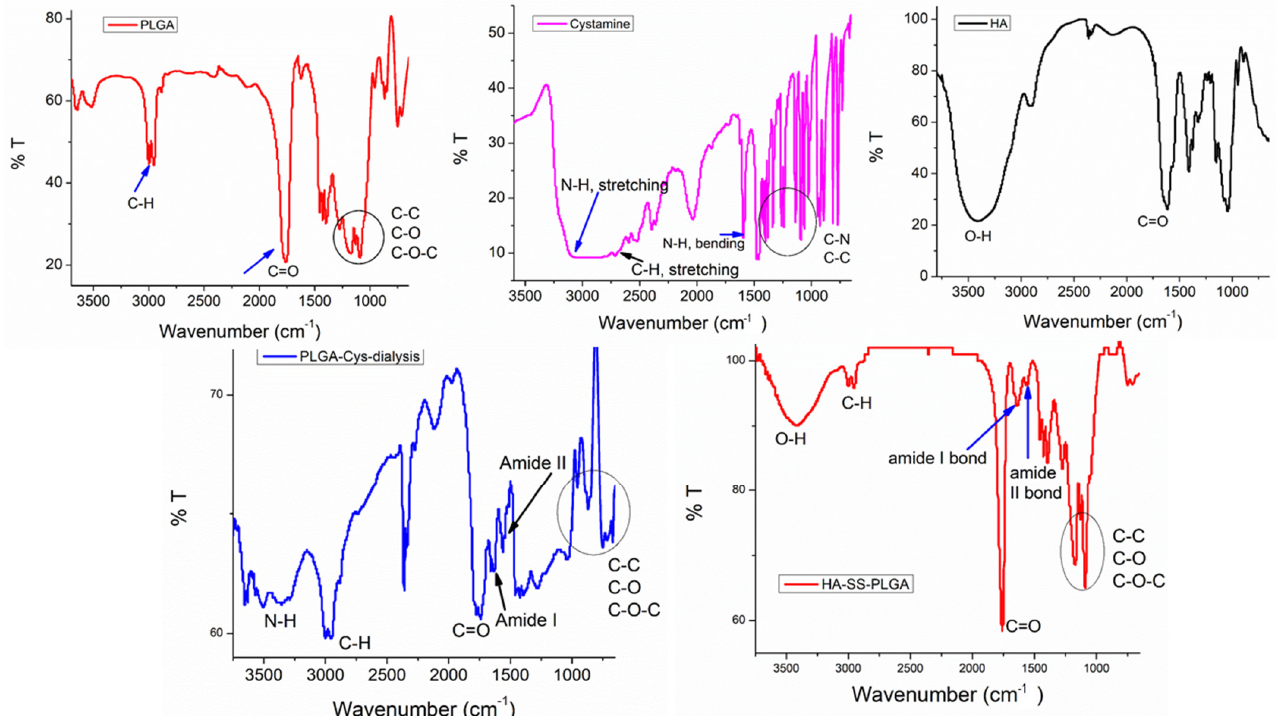
Figure 2. FTIR spectrum of HA-SS-PLGA and its precursors.